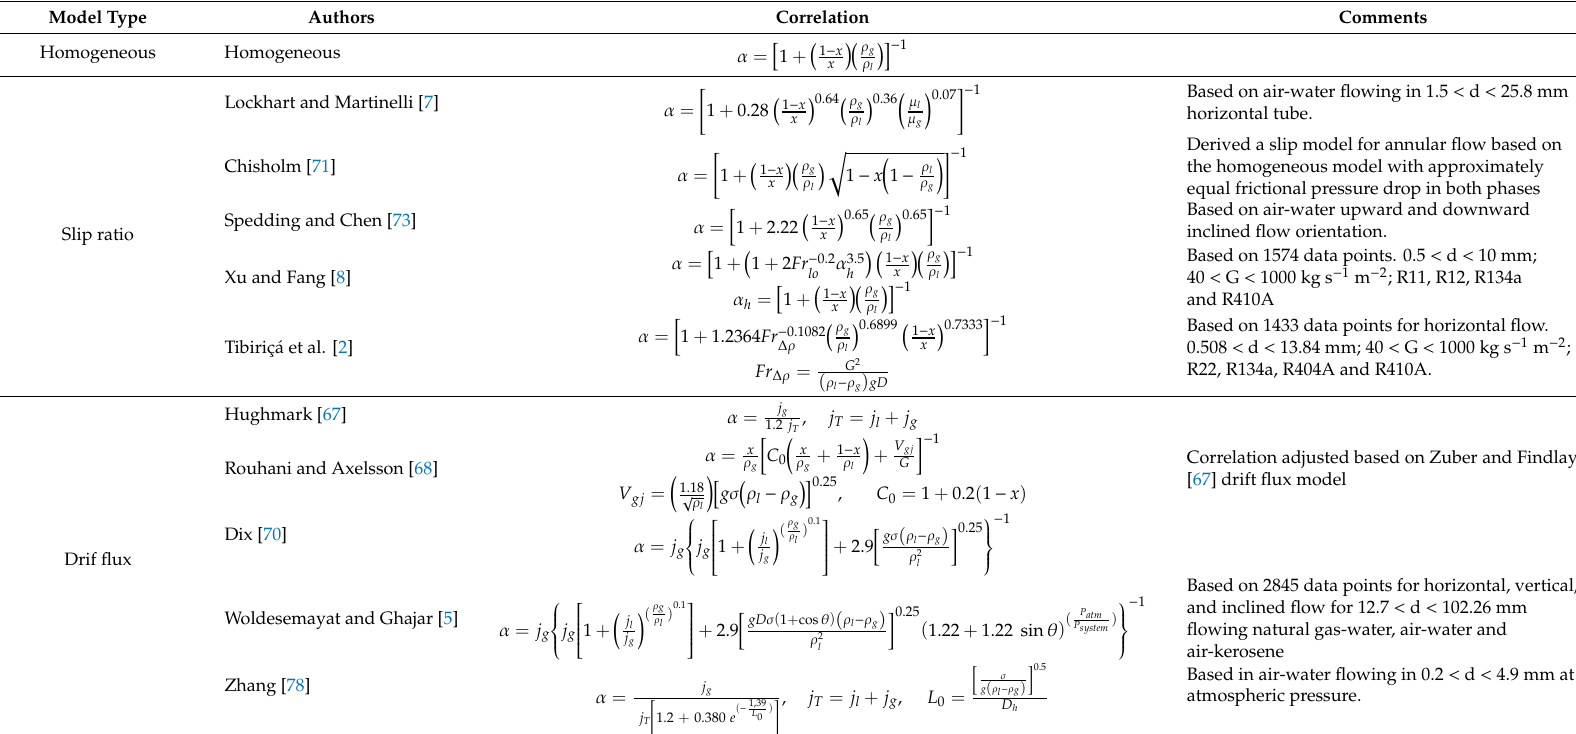
Table 6. Summary of the prediction method for void fraction evaluated on the current